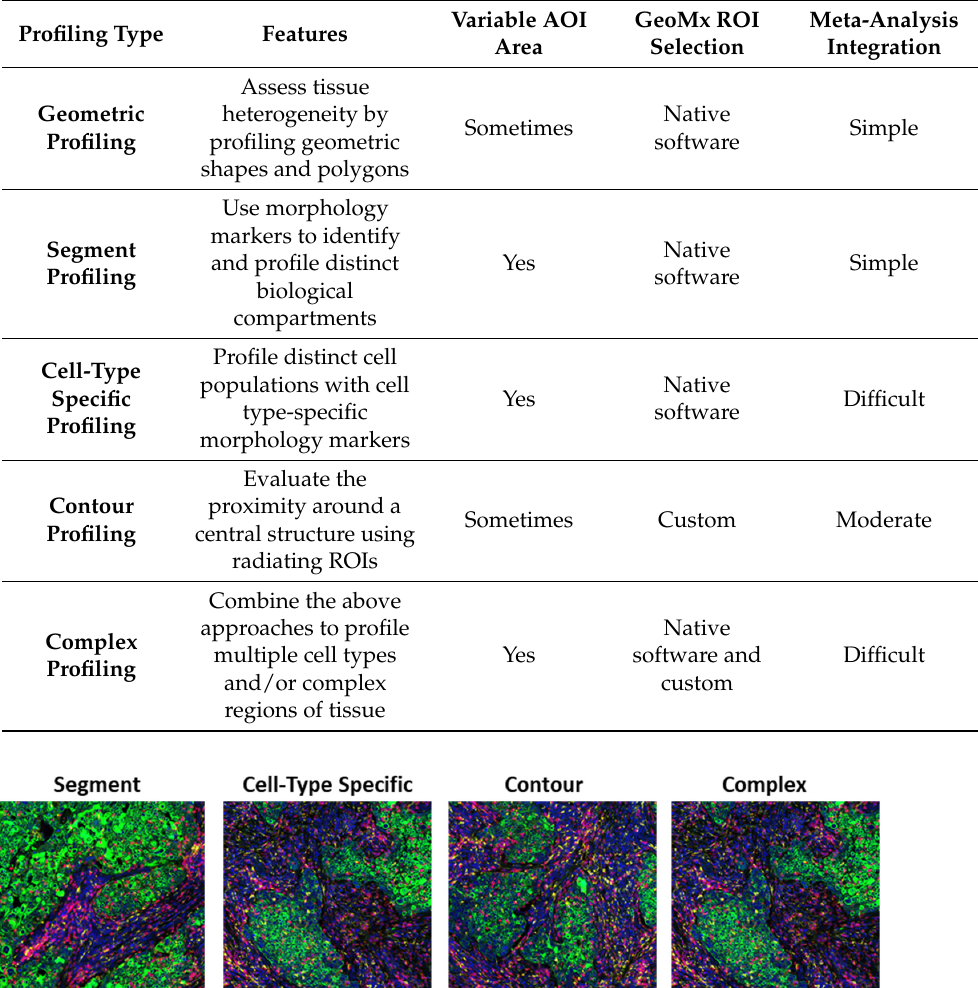
Table 1. AOI segmentation strategies and parameters around ROI selection.